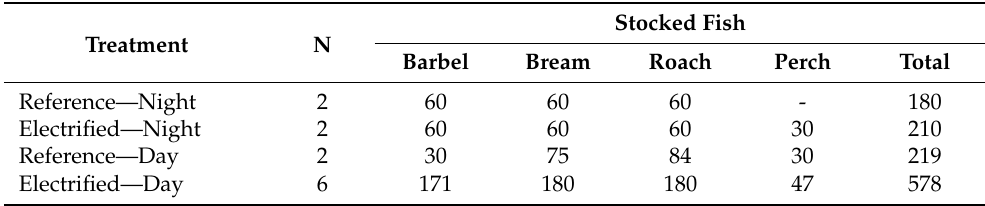
Table 2. Treatment conditions with number of replicates (N) and number of stocked fish according to the species used in the experiments and for the specific testing conditions: reference and electrified setup each during night and